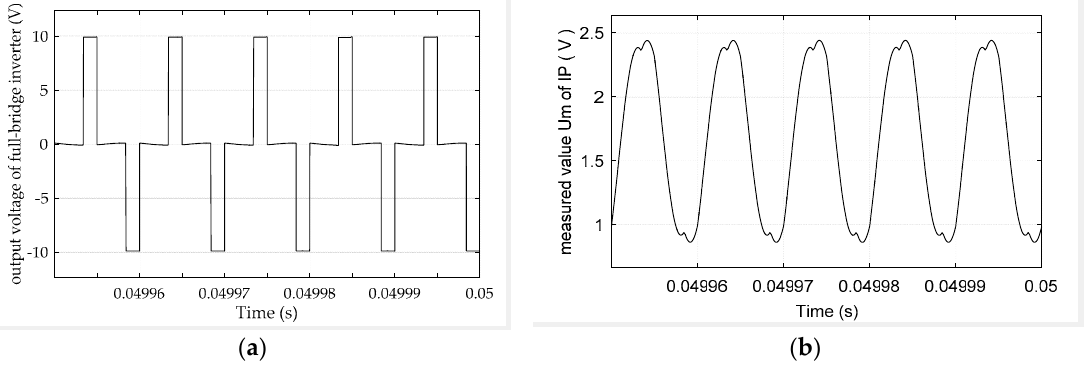
Figure 7. Input voltage and current of coupling compensation circuit: ( a ) output voltage of full-bridge inverter; and ( b ) measured value U M of I P .